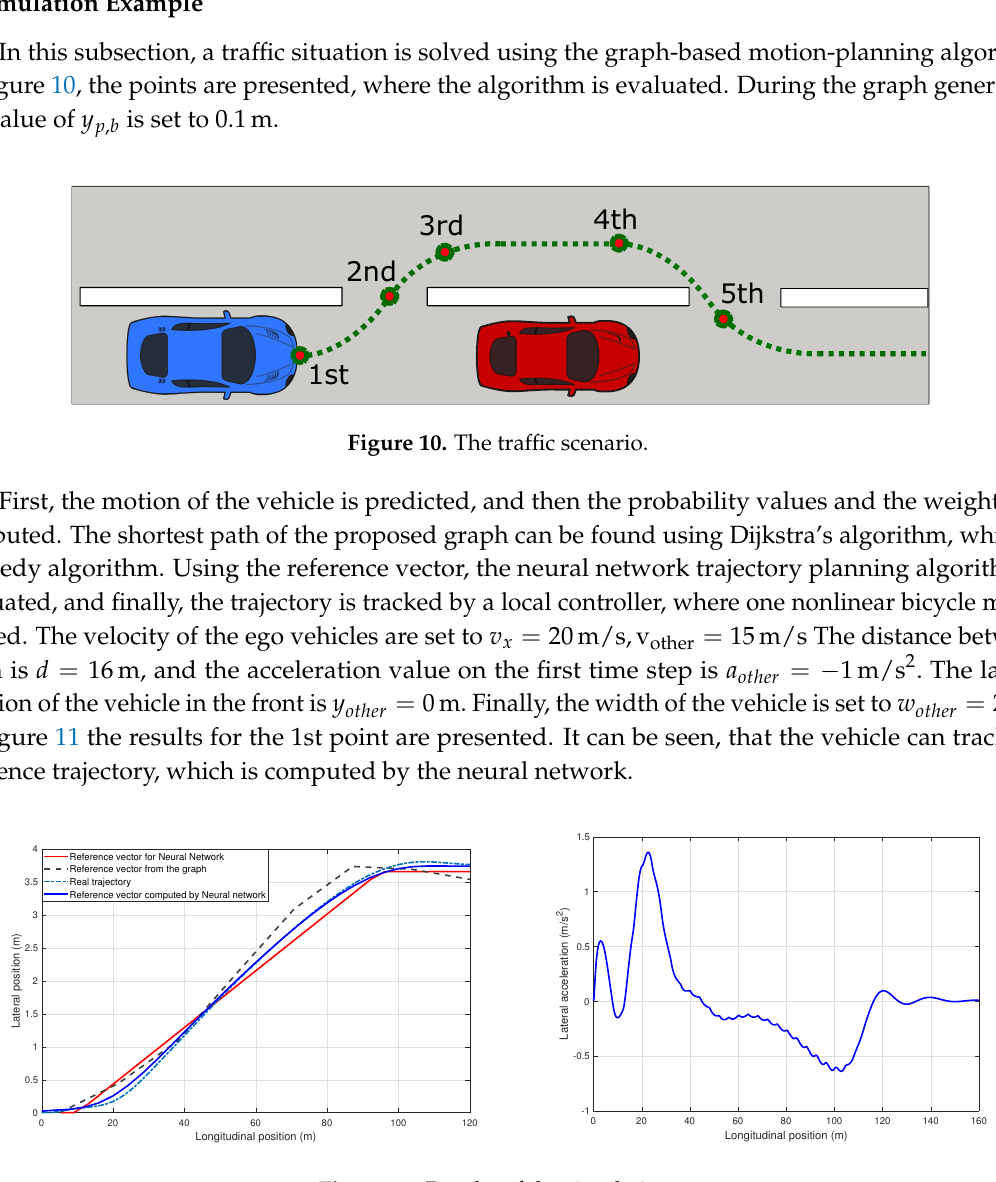
Figure 11. Results of the